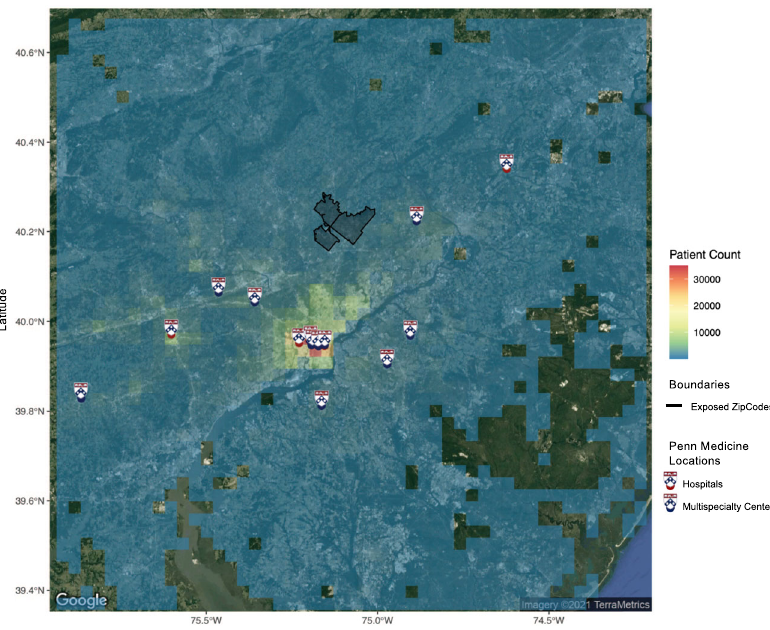
Fig. 3 Heatmap detailing density of overall cohort of Penn Medicine patients living in the Greater Philadelphia Area. Select points are censored. The PFAS exposed ZIP code boundaries (Horsham-Warminster-Warrington, PA) are shown in black solid line bordering. Penn Medicine Locations are marked with The Penn Shield, red point for hospitals and blue point for multispecialty centers. This is not an exhaustive map of all Penn Medicine locations (i.e., rehabilitation facilities, and so forth), but represents the major hospitals and multi-specialty centers within PennMedicine as of July 2021. A total of 9 of the 19 Penn Medicine locations are within the city of Philadelphia. The underlying base map is generated from the R package ggmap that uses a map from Maps Static API provided by Google Maps Platform. Additional layers and annotation provided by